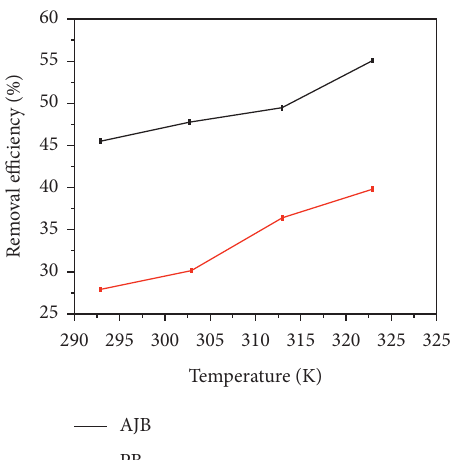
Figure 5: Comparison of the percentage removal of TPC by PB and AJB. Mass of adsorbent � 1.0g, initial TPC concentration, 1340.64 mg/L, 10mL of OMW, and contact time �